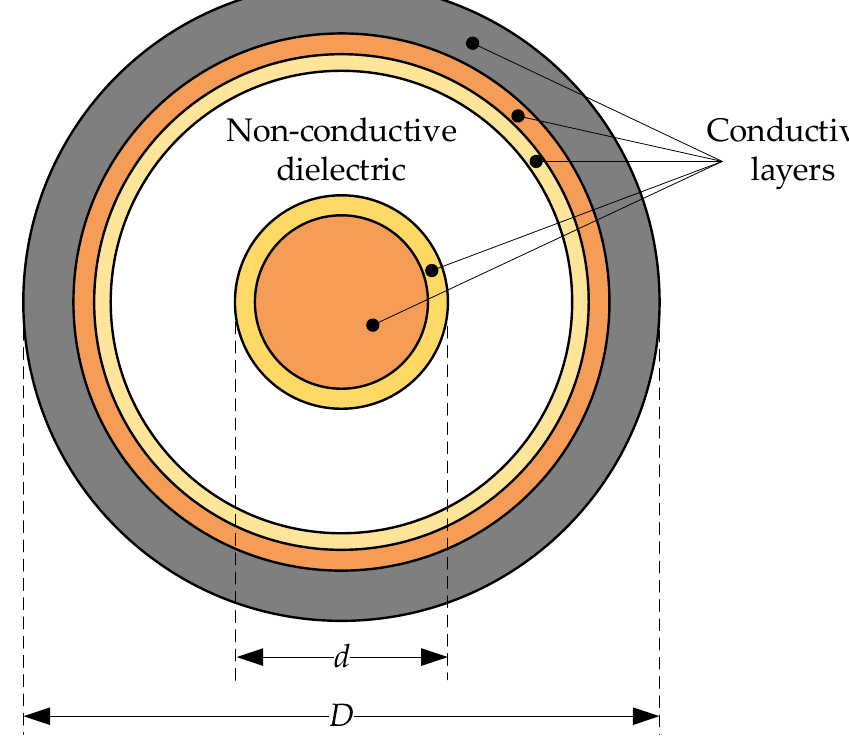
Figure 1. Example of a typical multilayer cylindrical waveguide.